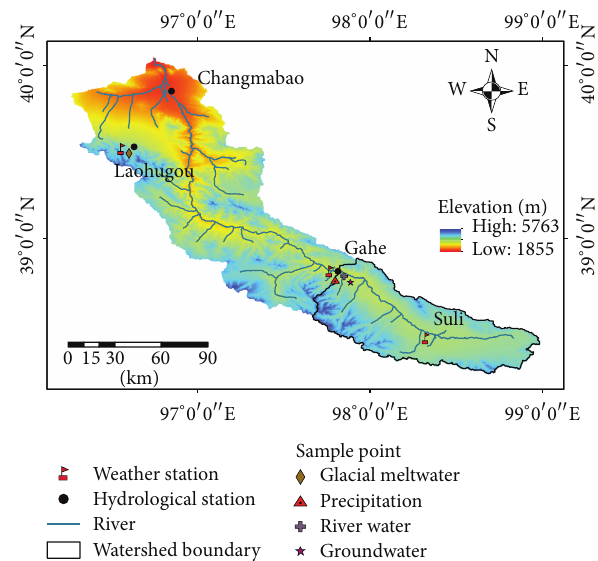
Figure 1: Site map showing the upstream of Shule River catchment and sampling sites.